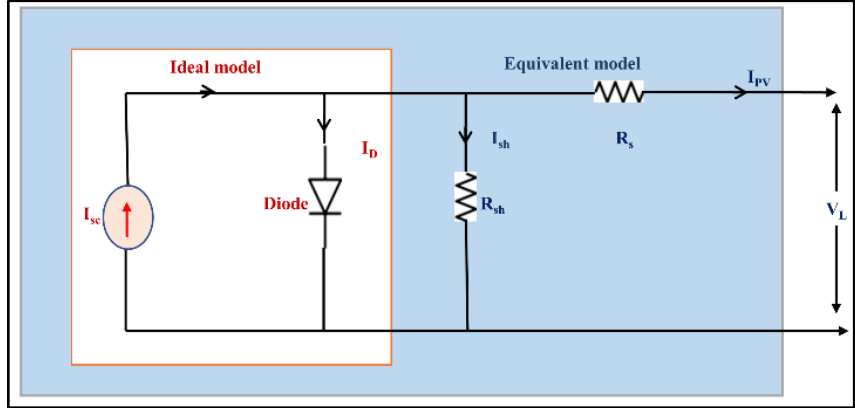
Figure 3 . Single-diode PV (SDPV) equivalent model . Figure 3. Single-diode PV (SDPV) equivalent model.